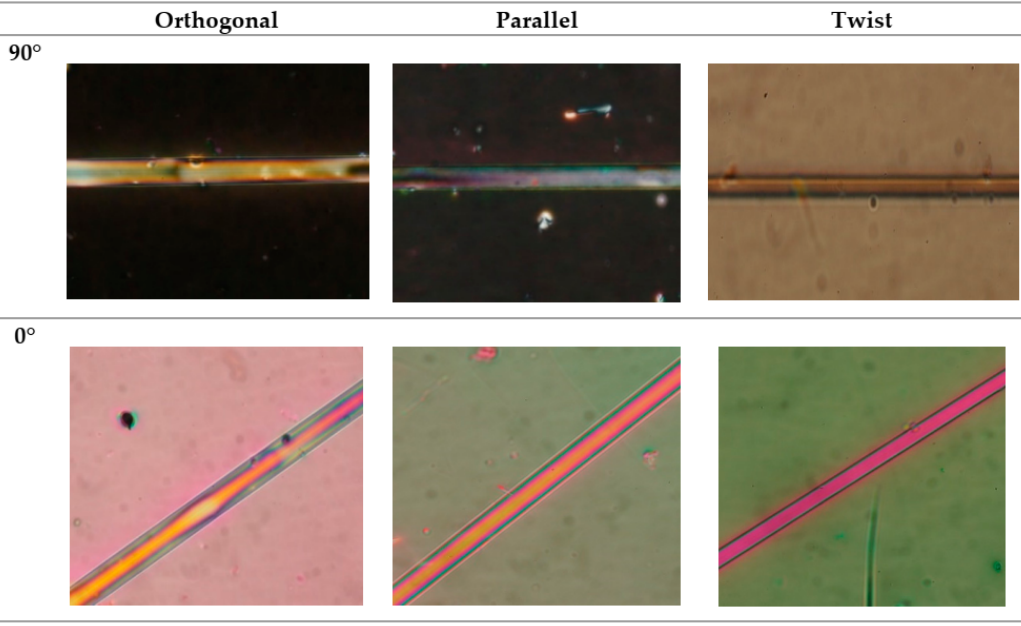
Figure 6. Photos of LC cells: orthogonal, parallel, and twist for crossed (90 ◦ ) and parallel (0 ◦ ) polarizers. Liquid crystals due to their chemical structure possess anisotropic physical